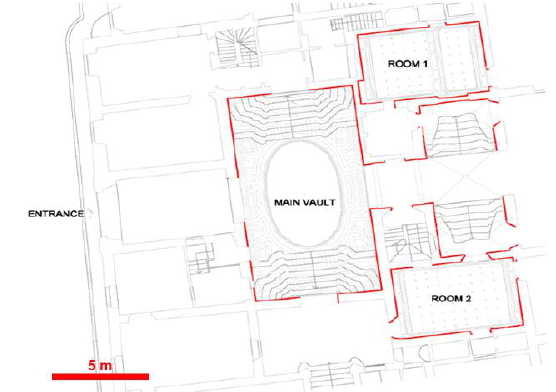
Figure 1. Plan of the original nucleus of the Sangallo’s House in Florence. In red you can see the rooms subject to the survey campaign with laser scanner described in this report, while the representation of the adjacent rooms has been inferred by a previous survey (by Arch. Ilaria